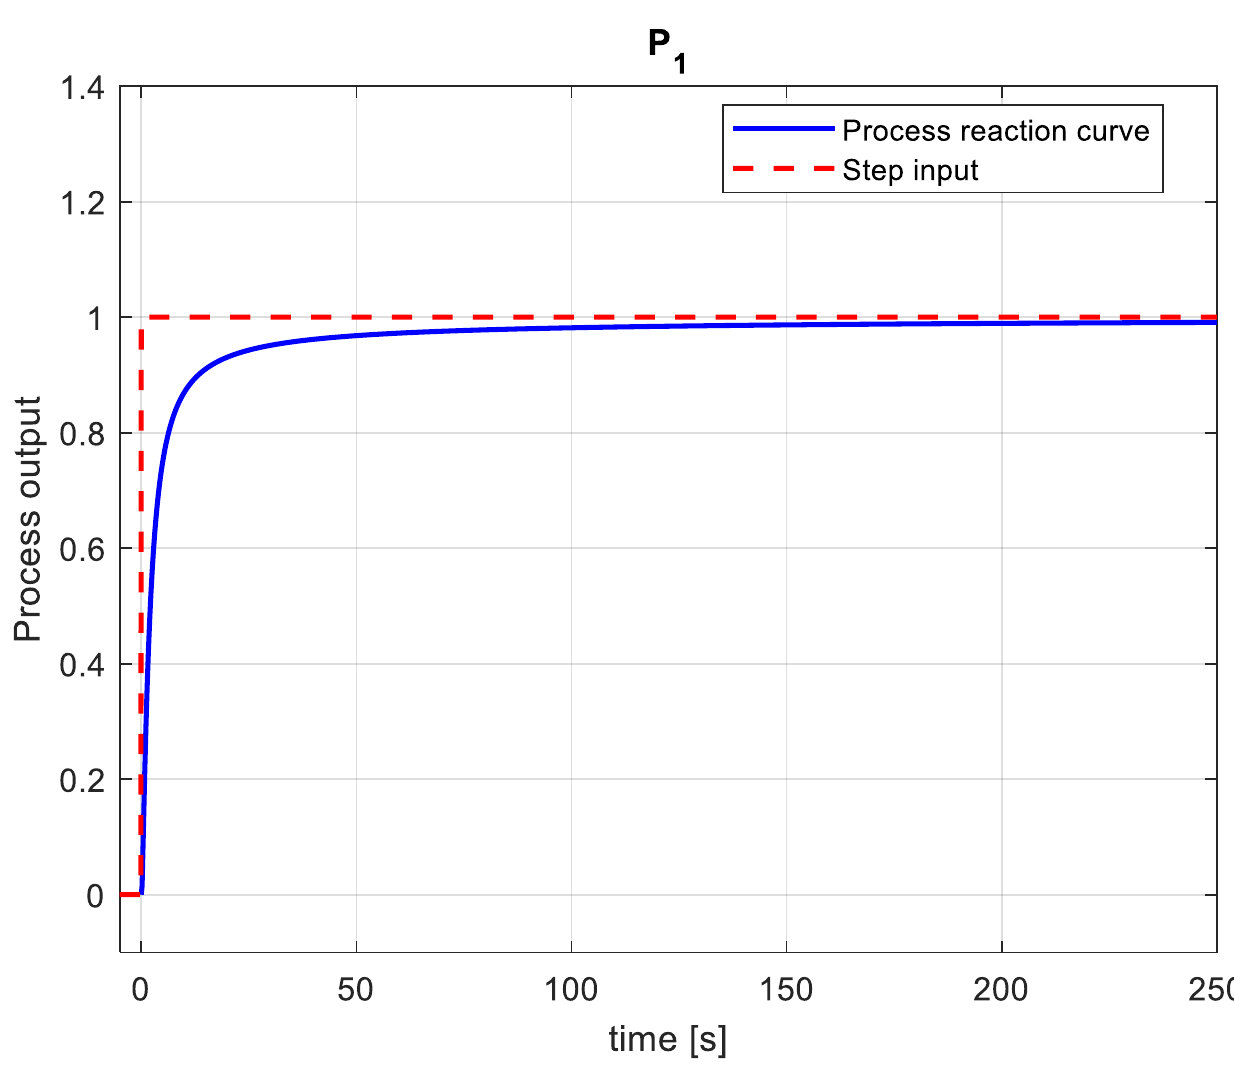
Figure 7. Process reaction curve for process P 1 and step-input signal. Table 11. Fractional-order model settings for the symmetrical and asymmetrical sets of points (5-